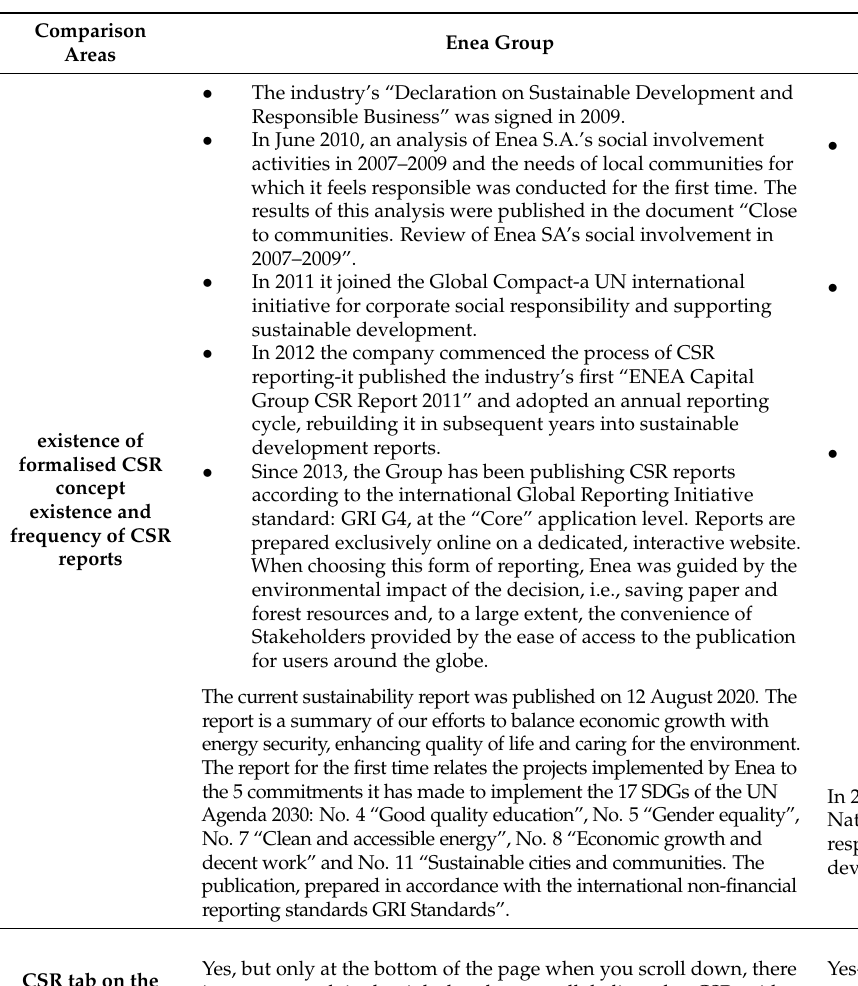
Table 2. Comparison of CSR disclosures among Energy companies listed on Warsaw Stock